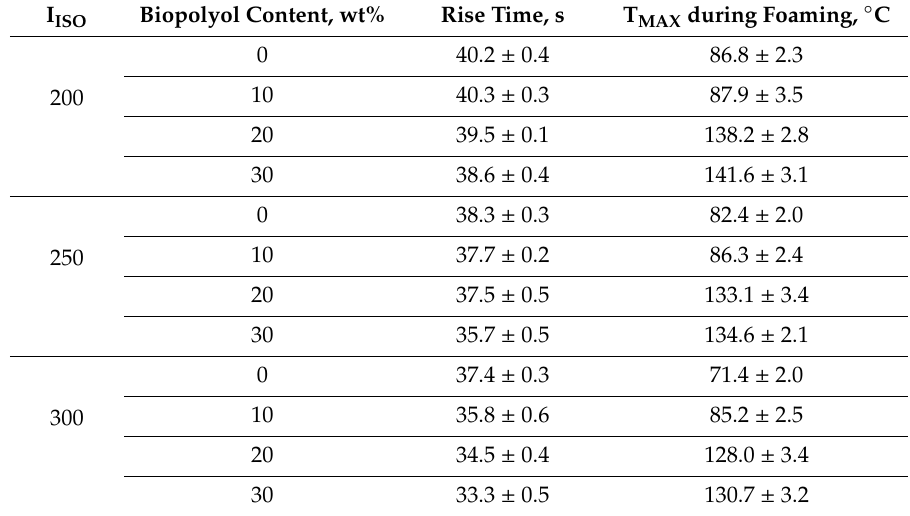
Table 3. Rise times and maximum temperatures recorded during the synthesis of PUR-PIR